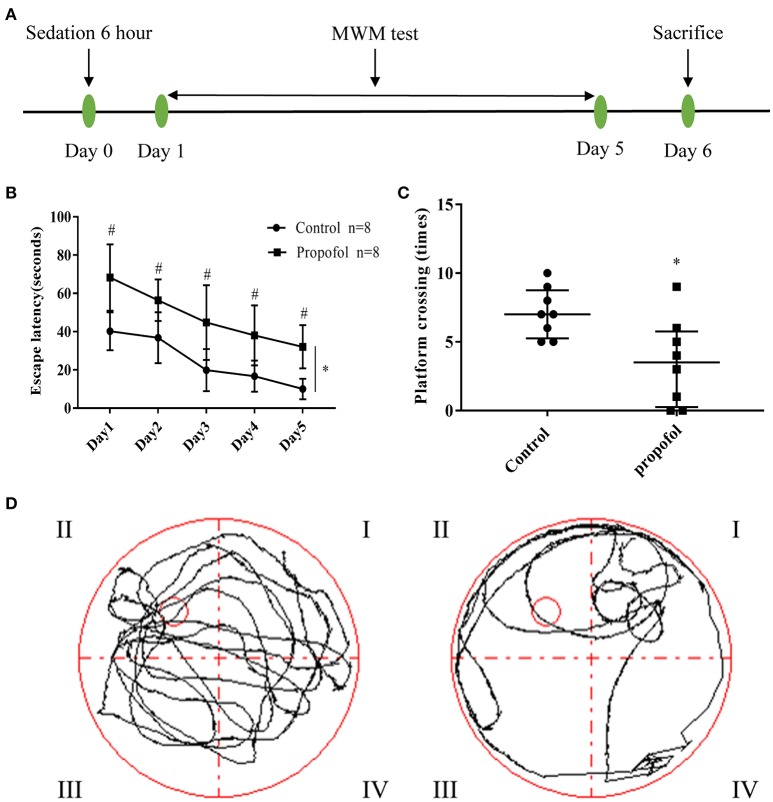
Experimental design and behavioral readouts of MWM tests. (A). Schematic illustration of the experimental design; (B) The latency of mice to reach the platform, in the two groups. Two-way ANOVA showed that propofol-induced anesthesia increases the escape latency of MWM, when compared with the control group. (*P < 0.05), the Bonferroni test shows that the propofol-treated mice have a longer escape latency compared to that of the mice receiving control treatment, from day 1 to day 5 (#P < 0.05 vs. control group at each day). Results are presented as mean ± standard error (n = 8, *P < 0.05); (C) Number of platform crossings in the probe trial. Results are presented as median and interquartile range (n = 8, *P < 0.05); (D) Representative searching swimming paths of two mice in the probe tests. (Left: Control group, Right: Propofol group).